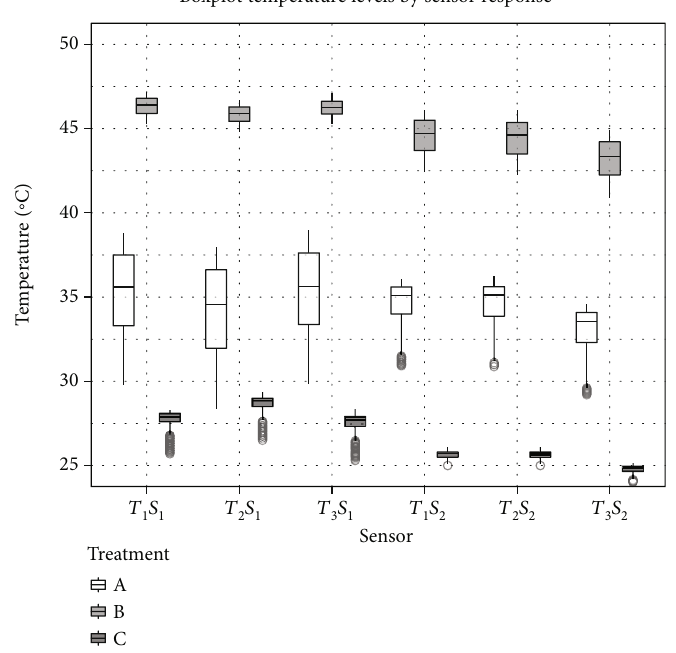
Figure 11: Boxplot temperature levels by sensor response per